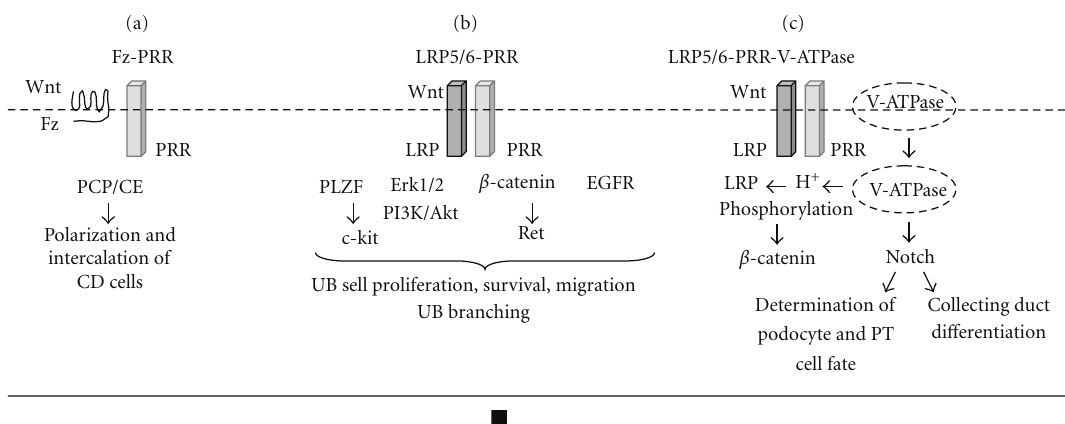
Figure 3: Proposed mechanisms mediating the e ff ect of the (pro)renin receptor (PRR) in metanephric kidney development. (a): PRR interacts with Wnt receptor frizzled (Fz) to regulate polarization and intercalation of collecting duct (CD) cells via planar cell polarity (PCP)/convergent extension (CE) Wnt signaling pathway [16, 25, 79]. (b): PRR may regulate UB branching by (1) inhibiting c-kit transcription via promyelocytic zinc finger transcription factor (PLZF) [73, 83, 84] (2) induction of Erk1/2, PI3K/Akt or epidermal growth factor receptor (EGFR) phosphorylation [52, 72, 73, 75, 85–87], and (3) interaction with LRP5/6 Wnt coreceptor leading to activation of β - catenin and Ret gene expression [22, 23, 56]. (c): PRR interacts with LRP5/6 and V-ATPase to form a complex at the plasma membrane. Following endocytosis, V-ATPase generates a gradient of H + ions that is essential for LRP5/6 phosphorylation and activation of β -catenin [56]. V-ATPase stimulates Notch signaling [88]. Notch acts to define the podocyte and proximal tubular cell fates [89] and regulates di ff erentiation of the CD cells